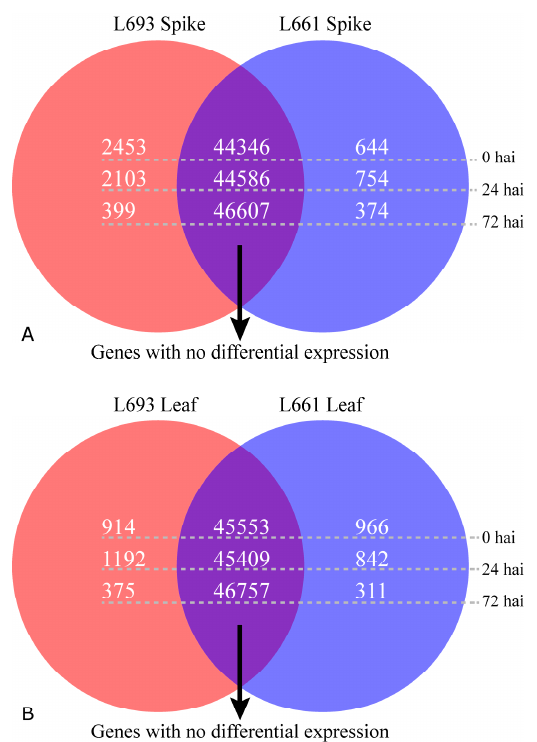
Figure 2. Comparison of differentially expressed genes in L693 and L661 following FHB infection. Number of upregulated genes (left, yellow circle), downregulated genes (right, blue circle), and genes without differential expression (middle, purple circle) in L693 (resistant) compared to L661 (susceptible) at 0, 24, and 72 h after inoculation (hai) in spike ( A ) and leaf ( B ).